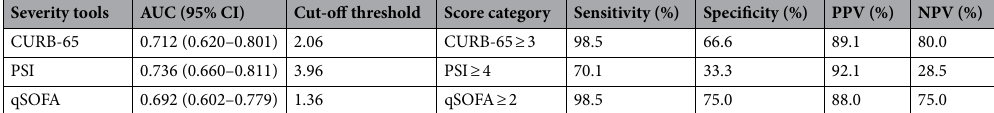
Table 5. Clinical utility of the three pneumonia severity scores for predicting in-hospital mortality (n = 79). The cut-off threshold was extracted from the ROC curves. AUC area under the receiver operating characteristic curve; CI confidence interval; CURB-65 confusion, urea, respiratory rate, blood pressure and age score; IPF idiopathic pulmonary fibrosis; NPV negative predictive value; PPV positive predictive value; PSI Pneumonia Severity Index; qSOFA quick Sequential Organ Failure Assessment; ROC receiver operating